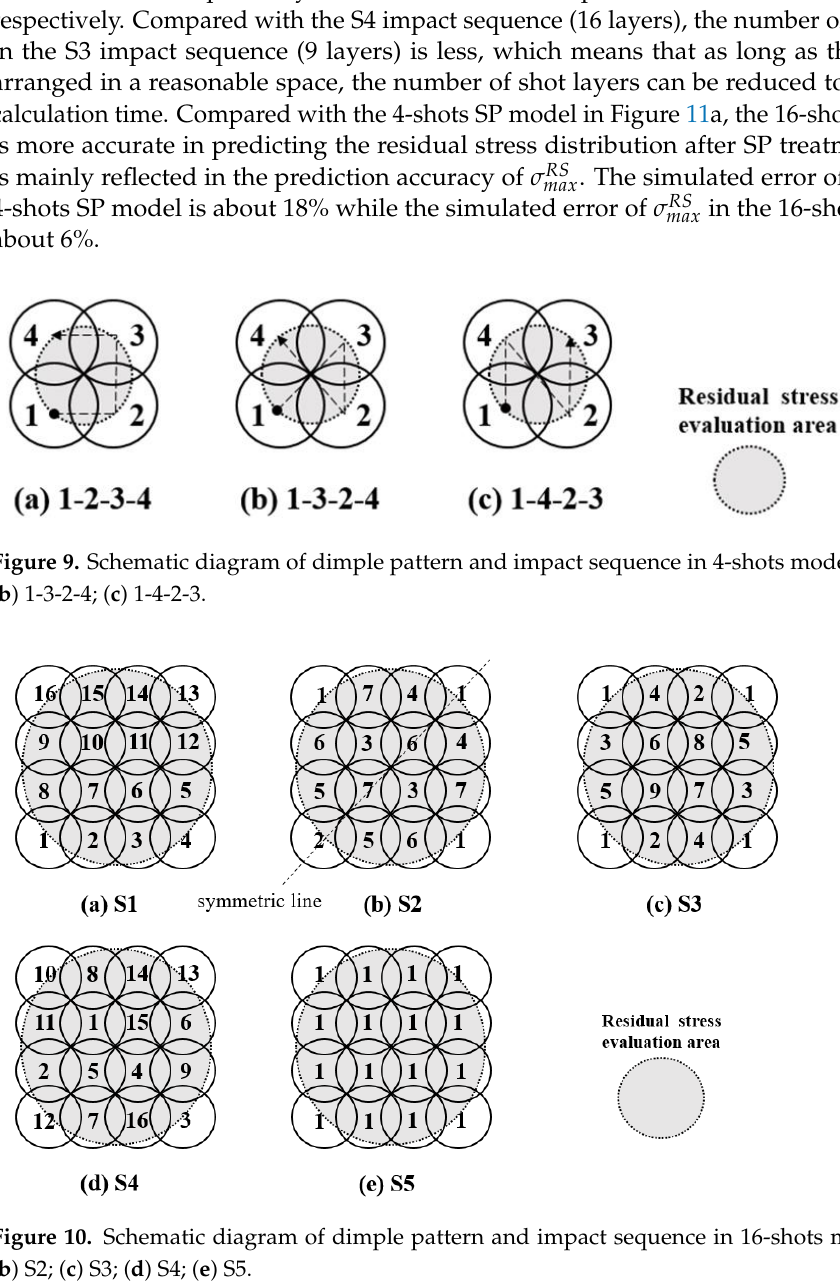
11 of 19 Figure 8. The residual stress depth profiles of four different vertical distance between shots (Z) SP models in the condition of ( a ) V = 60 m/s, d = 0.8 mm and C = 40% (W= 0.46 mm) and ( b ) V = 60 m/s, d = 0.8 mm and C = 20% (W = 0.66 mm). 3.2. The Effect of Impact Sequence on the Residual Stress State in Order Dimple Pattern SP Model As mentioned in Section 3.1, the shot distance affects the residual stress distribution in the SP model. A reasonable assumption of shot distance should be set according to the specific situation to improve the calculation efficiency and ensure the reliability of the residual stress prediction results. In the ordered dimple pattern SP model, apart from the dimple pattern arrangement, it is also interesting to consider whether the impact sequence will affect the residual stress field. Specifically, for the 100% coverage 4-shots SP model, in addition to the shot impact sequence 1-2-3-4 adopted in Section 3.1 Figure 7, there are